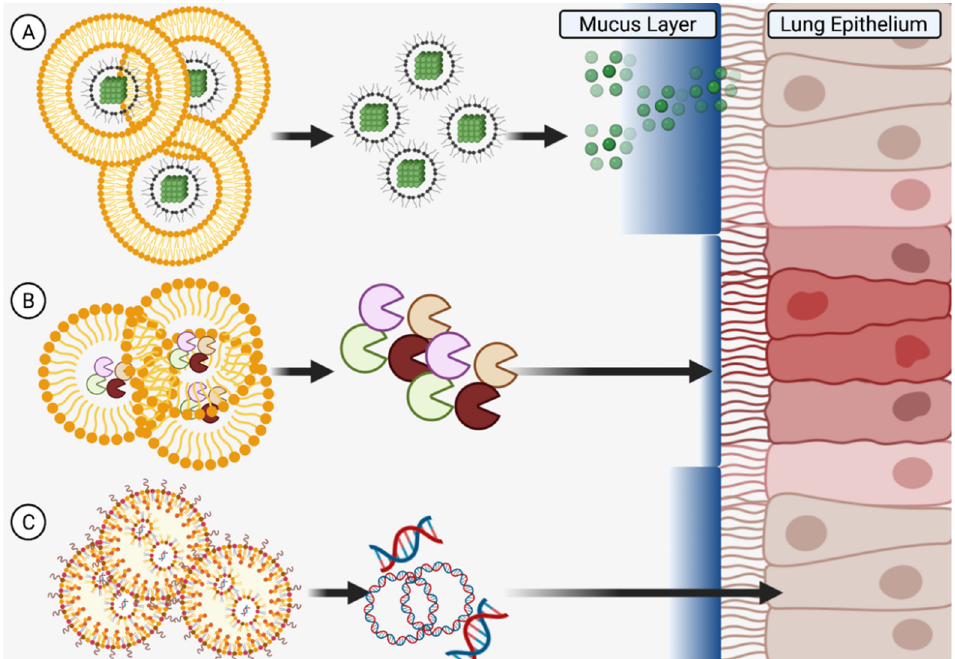
Figure 5. New Horizons in Delivery Potential. Microscale structures can be engineered to ( A ) carry nanoscale particles deep into the lungs and past the mucous barrier, ( B ) release enzymes to locally modify the mucous for easier penetration of subsequent medicines, or ( C ) release gene therapy materials to change mucous expression profiles. Created in BioRender.com.